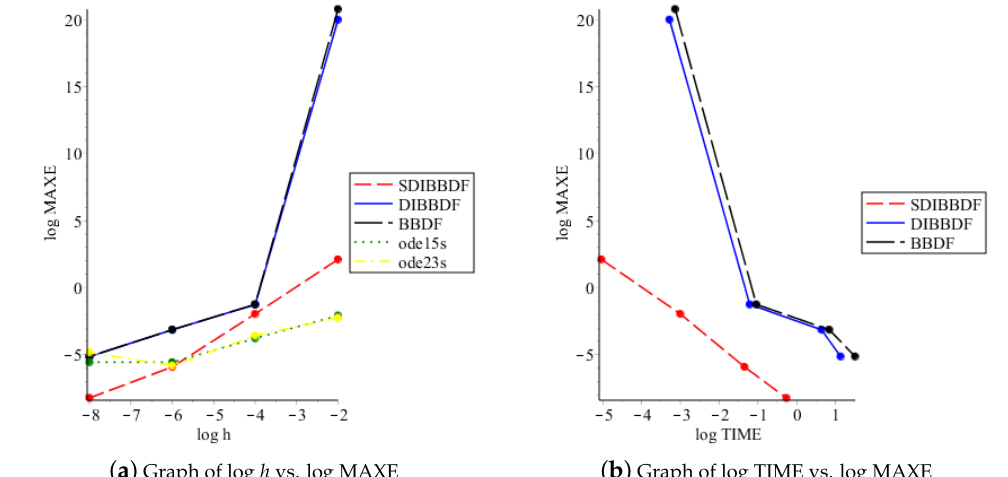
Figure 8. Efficiency curves for test problem 4.